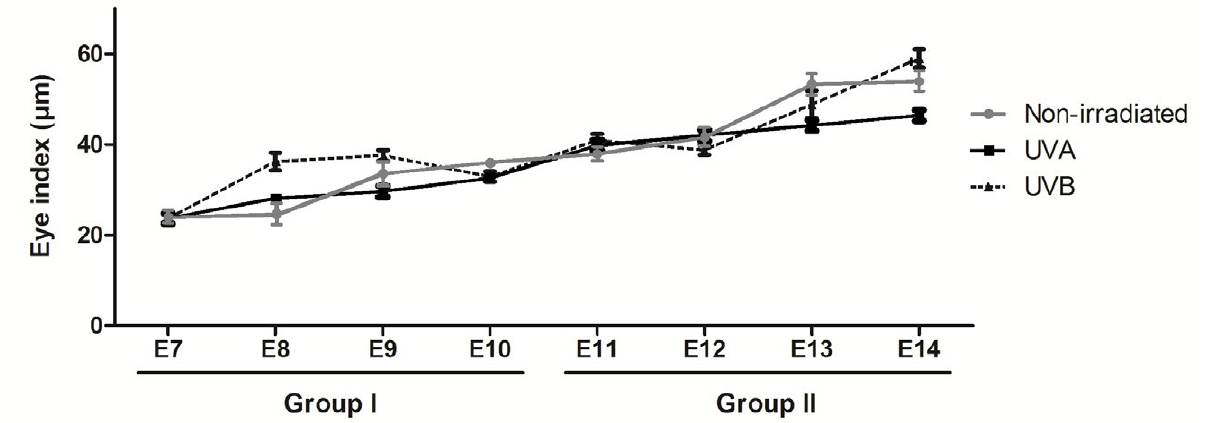
Figure 2. Eye index of embryos of Macrobrachium olfersii from groups I and II following UVA and UVB exposure. Data are presented as the mean ± SEM. Gray, black, and dashed lines correspond to non-irradiated, UVA-irradiated, and UVB-irradiated embryos, respectively.